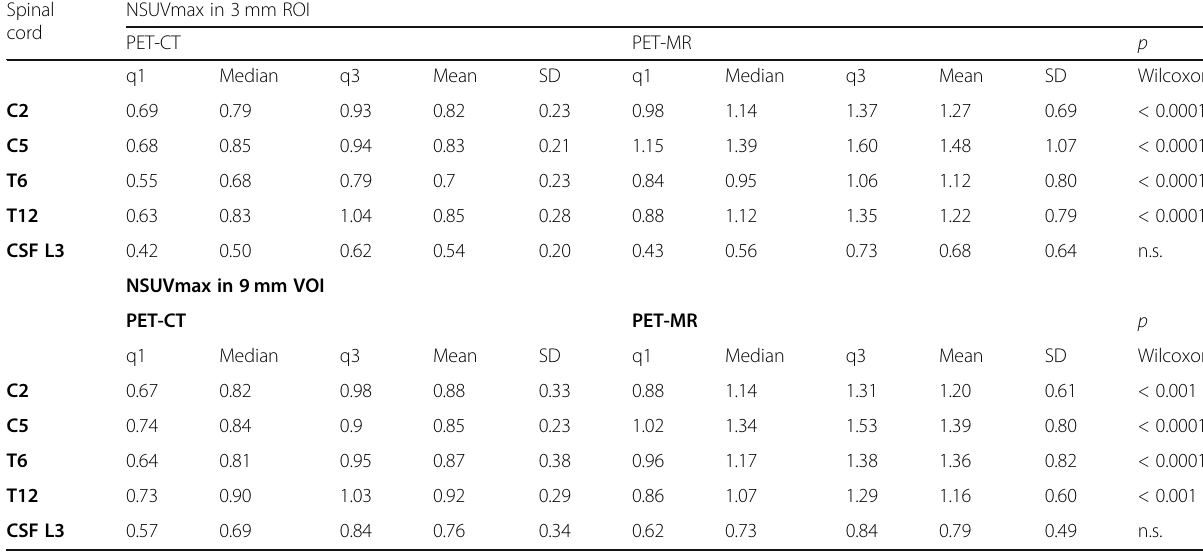
Table 1 Median, 1st and 3rd quartile of NSUVmax values measured in the spinal cord in both PET-CT and PET-MR, with 3 mm ROI and 9 mm VOI Spinal